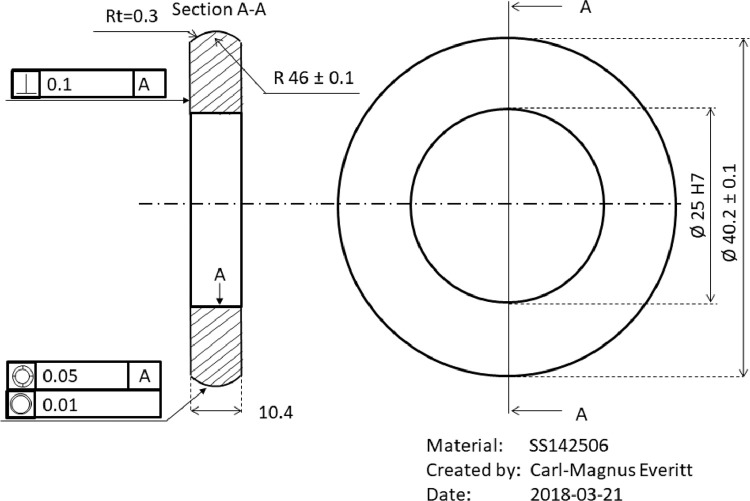
The counter-disc.